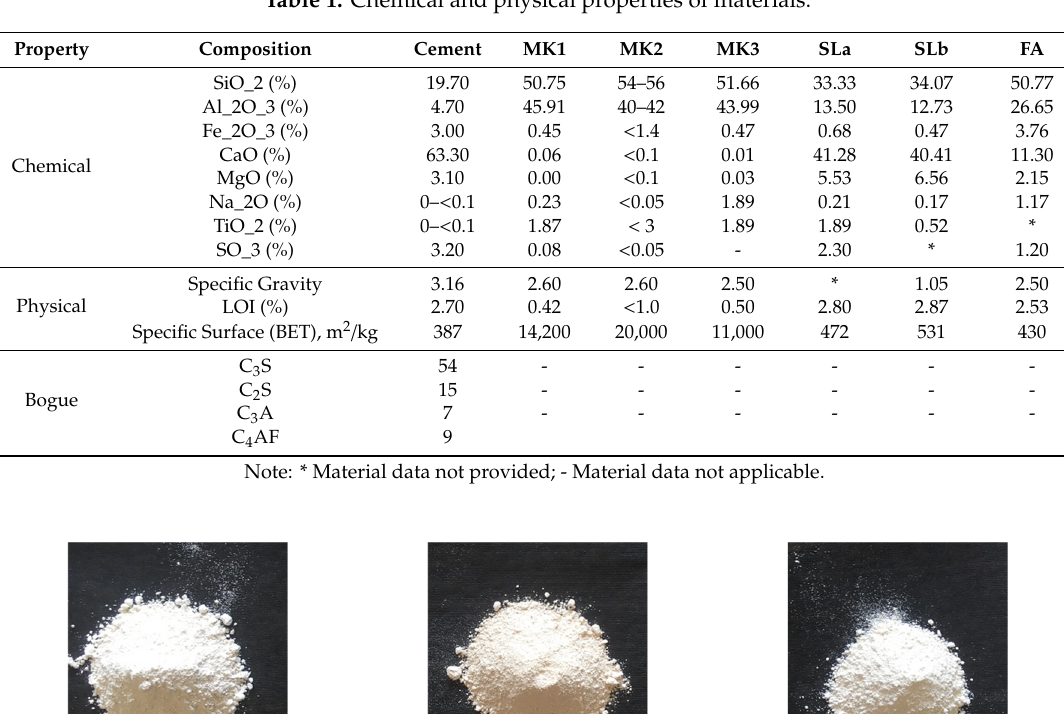
Table 1. Chemical and physical properties of materials.